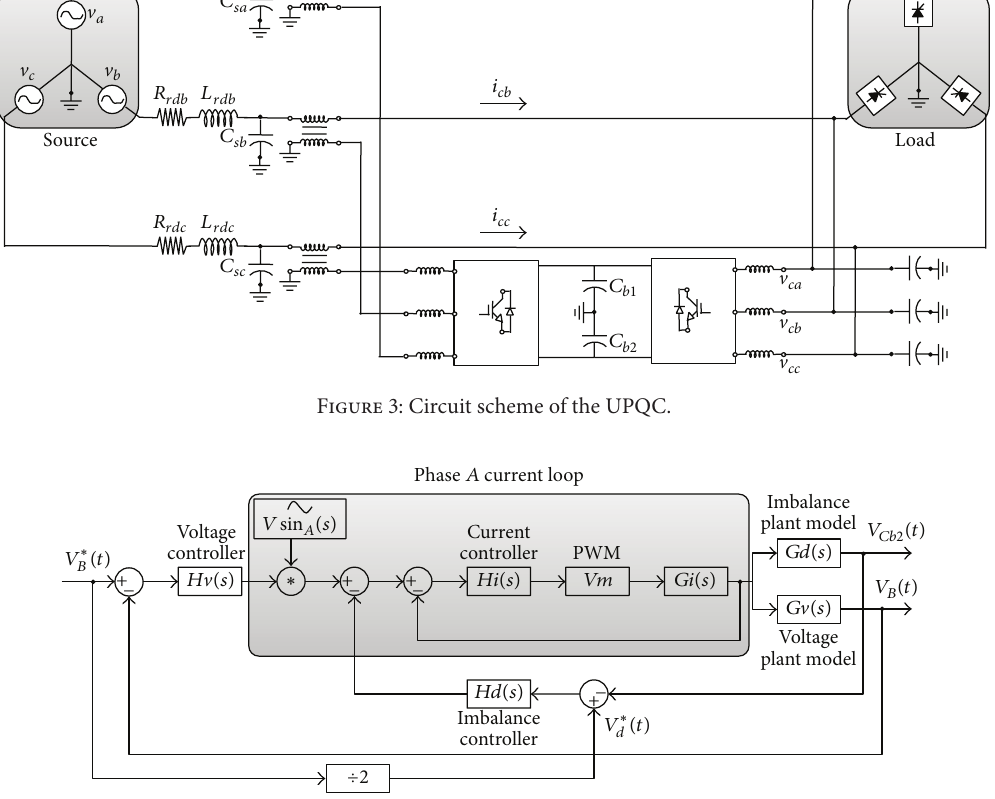
Figure 4: Block diagram of the UPQC control loops.